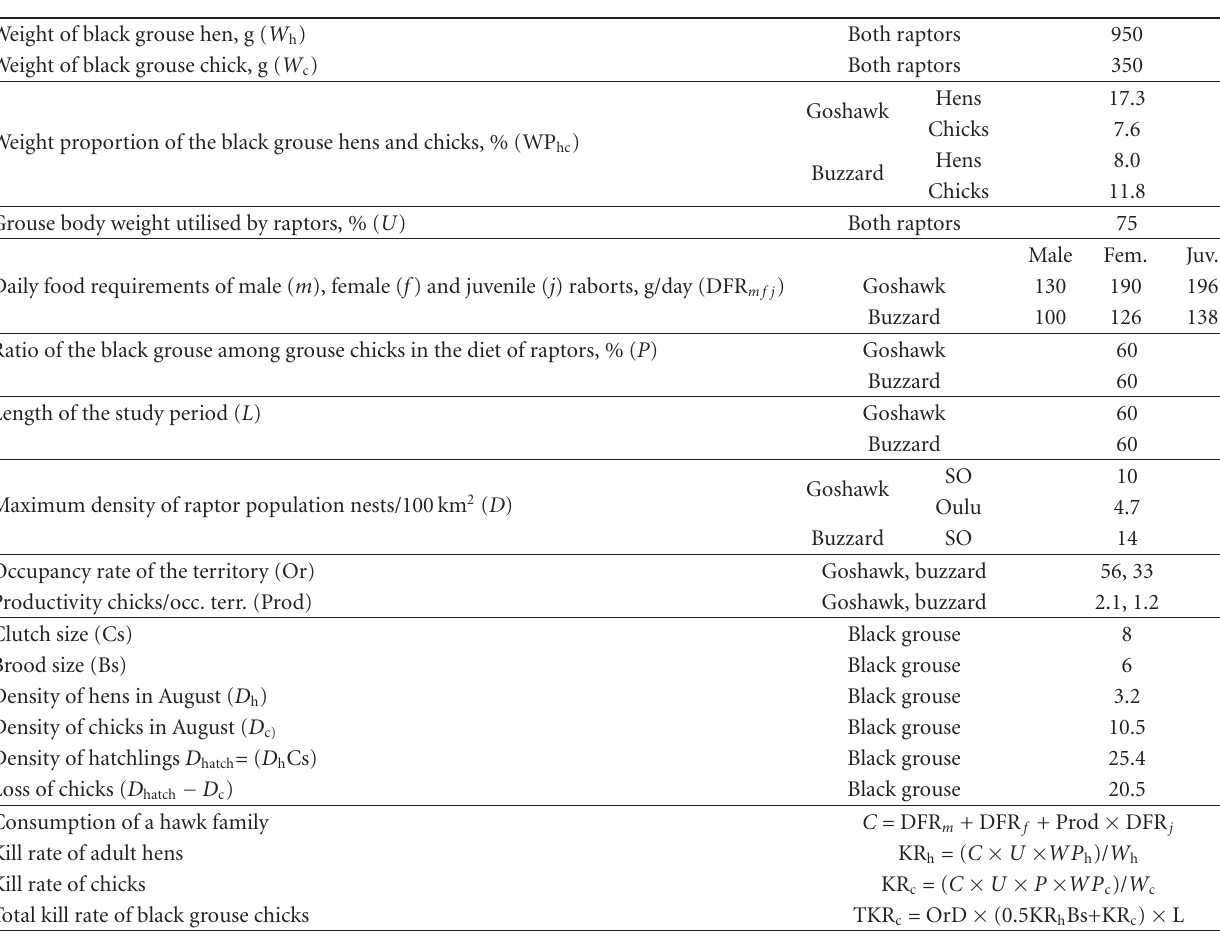
Table 3: Some of the main original data used and calculation performed for estimation of raptor predation impact on juvenile grouse (only mean values are